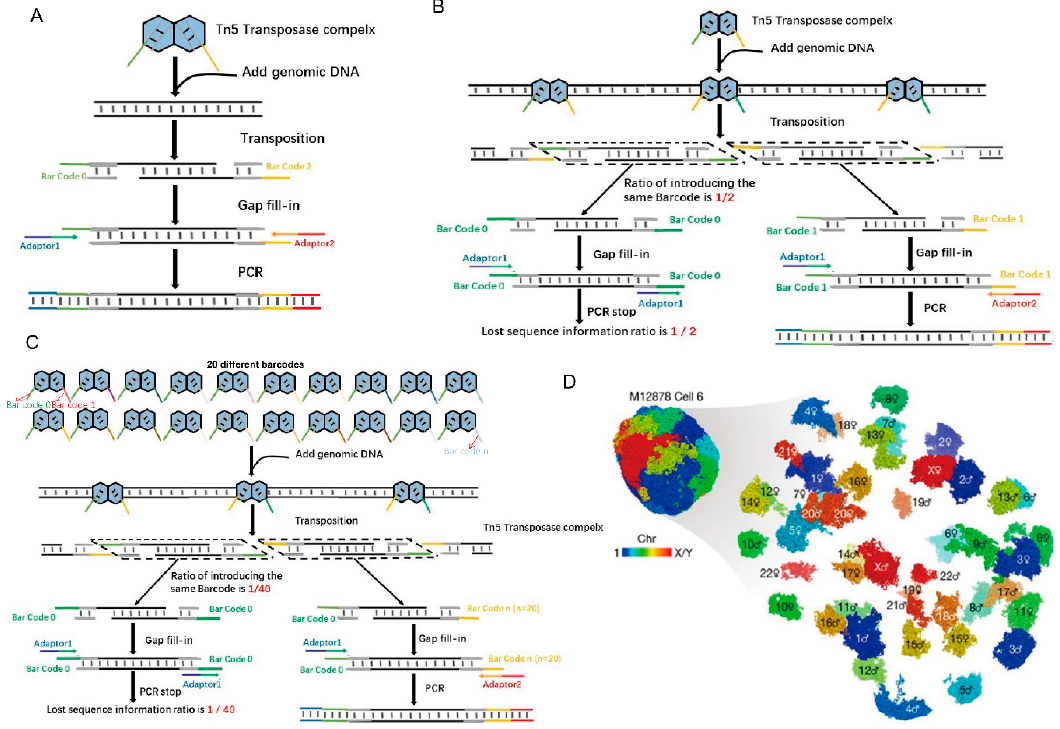
Figure 2. Tn5 in reconstructing 3D genome structures. ( A ). Tn5 is used to form a composite with barcodes, and then adapters are added by PCR. ( B ). The traditional method of Tn5 transposition using two barcodes results in the loss of 50% of the genomic sequence information. ( C ). Dip-C sequencing